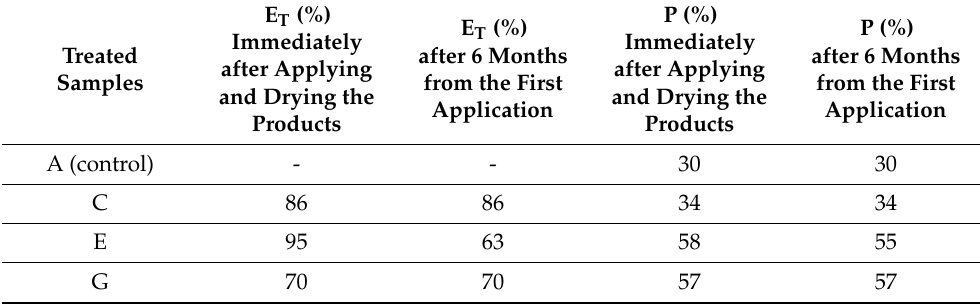
Table 8. Evaluation of the treatment Efficiency (E T %) and the water permeability coefficient